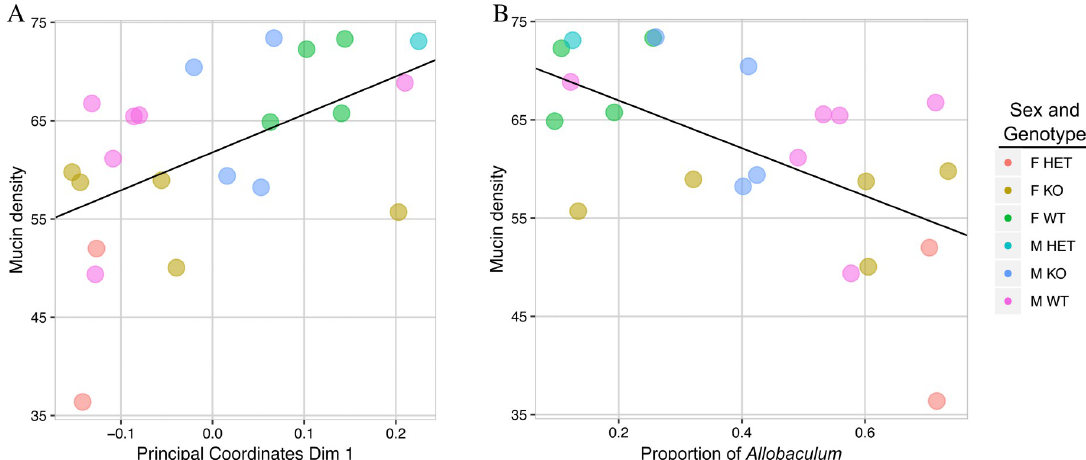
Fig 8. Relationship between mucin density and microbial community in the mouse colon. (A and B) The y-axes in each graph show mucin density values for a subset of the mice. The x-axis shows (A) the first dimension of principal coordinates from the analysis of weighted UniFrac measurements between the microbial communities or (B) the relative proportion of Allobaculum in each 10-week old mouse. A regression line describing the linear relationship between each of the two variables and mucin density is shown. Spearman rho = 0.53472, p = 0.01142 and Spearman rho = -0.53811, p = 0.01083 for each of the comparisons